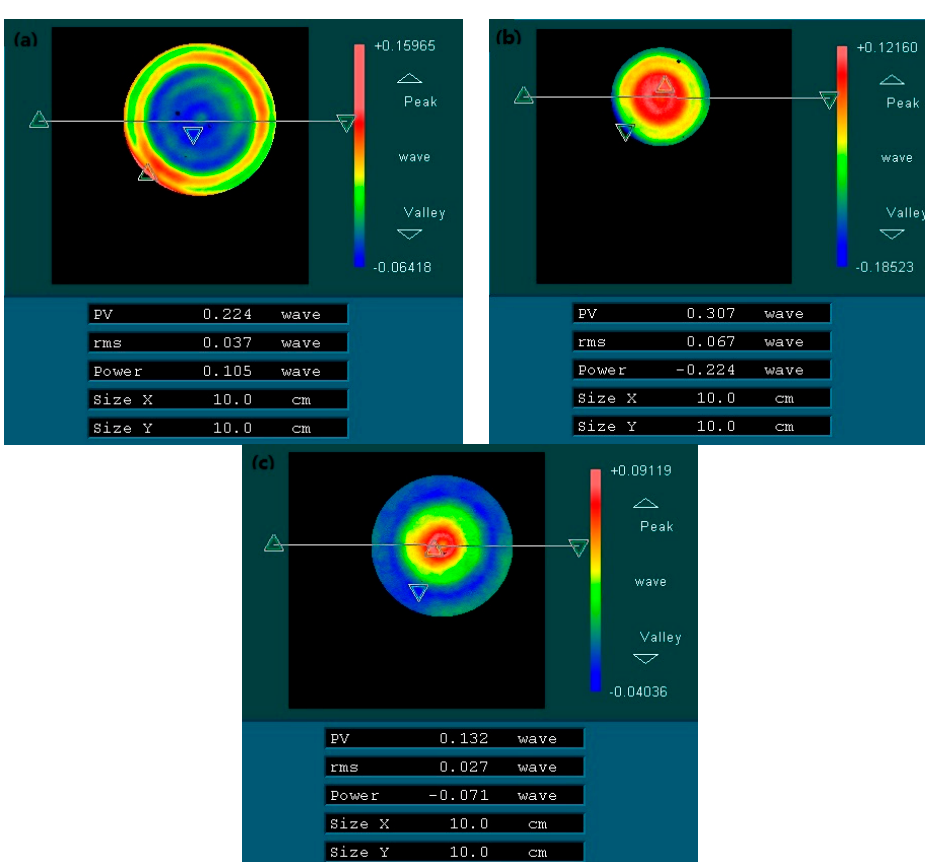
Figure 8. Surface figure measurement: ( a ) substrate; ( b ) post-deposited; ( c ) backside coating compensation.